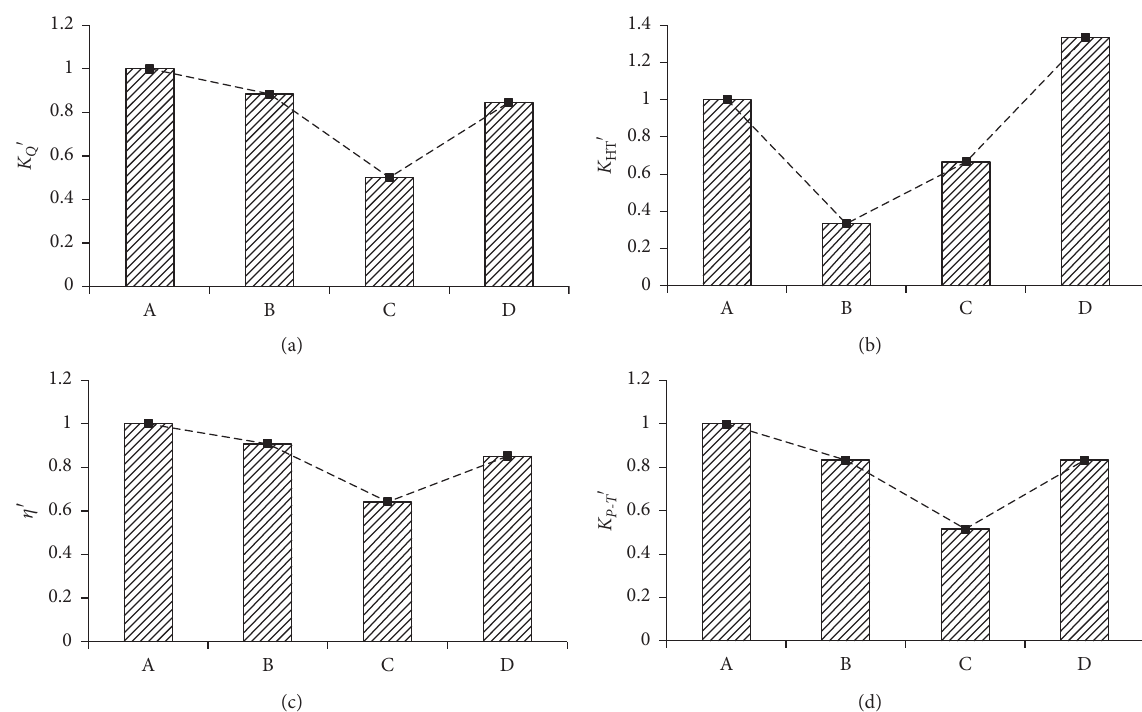
Figure 6: Range diagram of each parameter for different factors: (a) K 0.00.20.40.60.81.01.21.4 H ′